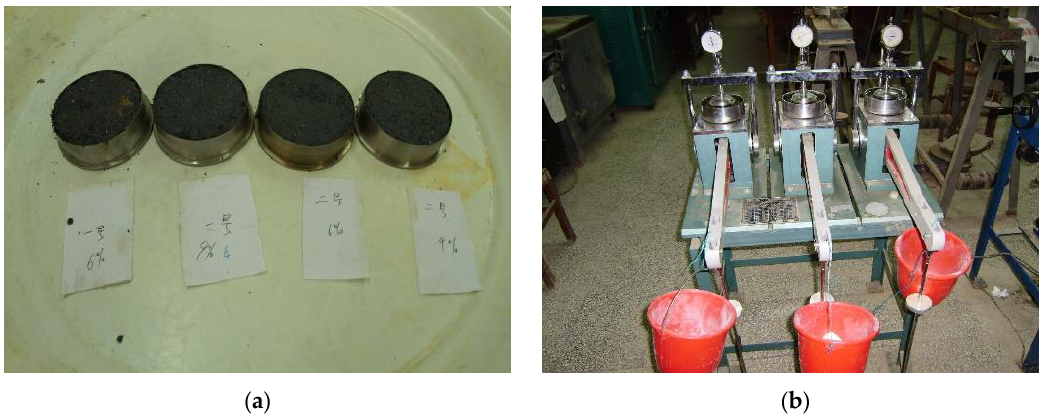
Figure 5. ( a ) Remodeling of rock sample; ( c ) lever-type consolidometer expansibility test.